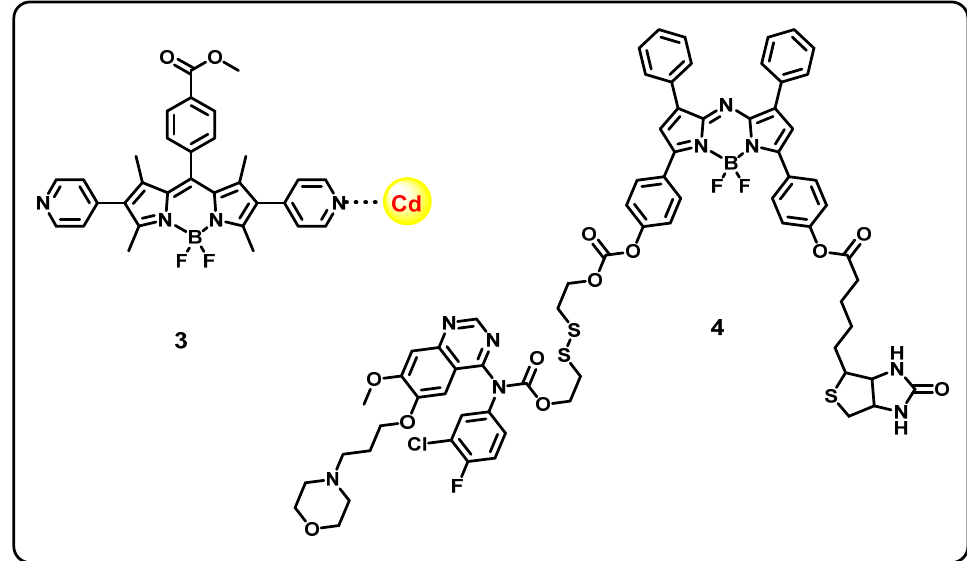
Figure 8. Structure of MOF-based BODIPY ( 3 ) and Azo-BODIPY ( 4 ).